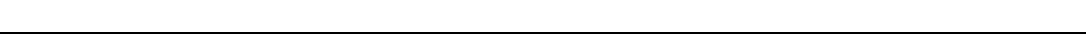
Fig. 2 Subcellular protrusion phenotypes revealed by a time series clustering analysis. a – c A representative cluster assignment on a time-lapse movie of a PtK1 cell stained with CellMask DeepRed. Edge evolution on 5 s interval ( a ), cluster assignments of each probing window on every four frame (20 s interval) ( b ), and the space-time maps of instantaneous edge velocity ( c ) of the entire cell edge and the indicated cluster regions. Scale bar: 10 μ m. d Raw velocity maps for Cluster I, II-1, II-2, II-3, and III. All time series are registered with respect to protrusion onset ( t = 0). e Average time series of protrusion velocity registered at protrusion onsets ( t = 0) in each cluster. Solid lines indicate population averages. Shaded error bands indicate 95% con fi dence intervals of the mean computed by bootstrap sampling. n indicates the number of time series in each cluster. The time lapse movies of 36 cells were used in this analysis. f Proportions of each cluster in entire samples or individual cells expressing fl uorescent actin, Arp3, VASP, and HaloTag, respectively. g Decision graph of the density peak clustering analysis of protrusion velocities. h A t-SNE plot of the autocorrelation functions of protrusion velocity time series overlaid with cluster assignments. i Spatial conditional distribution of each cluster. Solid lines indicate population averages. Shaded error bands indicate 95% con fi dence intervals of the mean computed by bootstrap